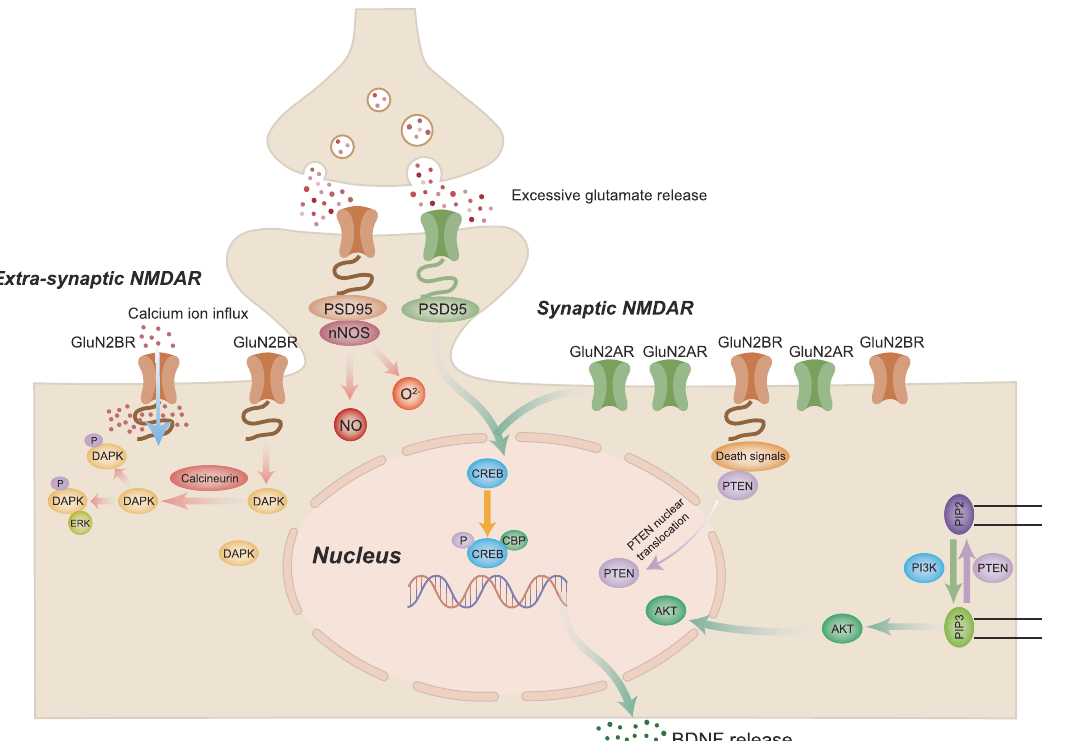
Fig. 3 Excitotoxicity and signaling pathways involved in ischemic stroke. NMDAR N-methyl-D-aspartate receptors, PI3K Phosphatidylinositol 3 kinase, BDNF Brain-derived neurotrophic factor, CREB cAMP-response element-binding protein PTEN Phosphate and tension homology deleted on chromosome ten, PIP3 plasma membrane intrinsic protein 3, DAPK1 Death-associated protein kinase 1, PSD95 Postsynaptic density protein 95, nNOS Neuronal nitric oxide